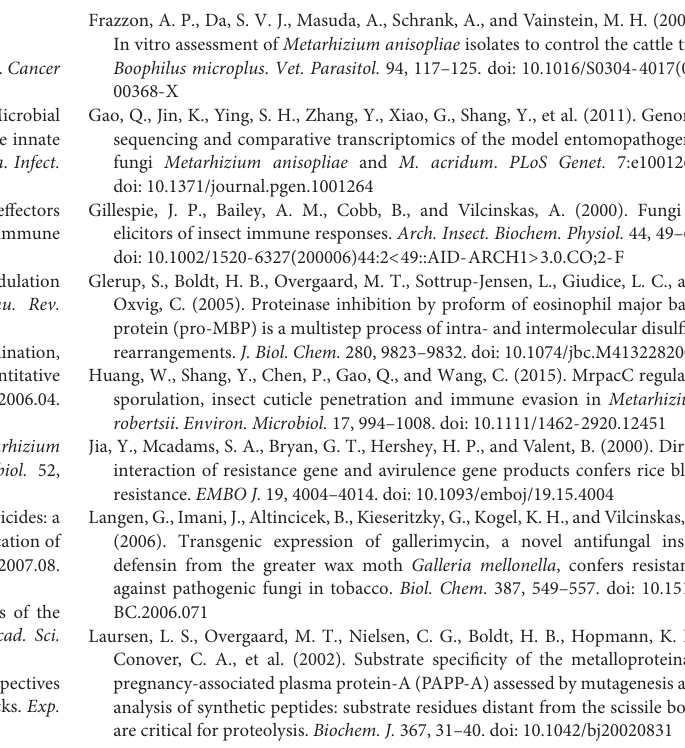
FIGURE S1 | Deletion of genes encoding metalloproteases in M. robertsii . (A) The disruption and complementation plasmids of Mrmep1 . (B) The disruption and complementation plasmids of Mrmep2